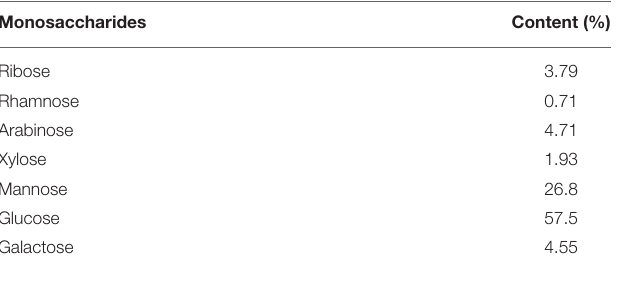
TABLE 1 | Monosaccharide compositions in the exopolysaccharide from S. commune.